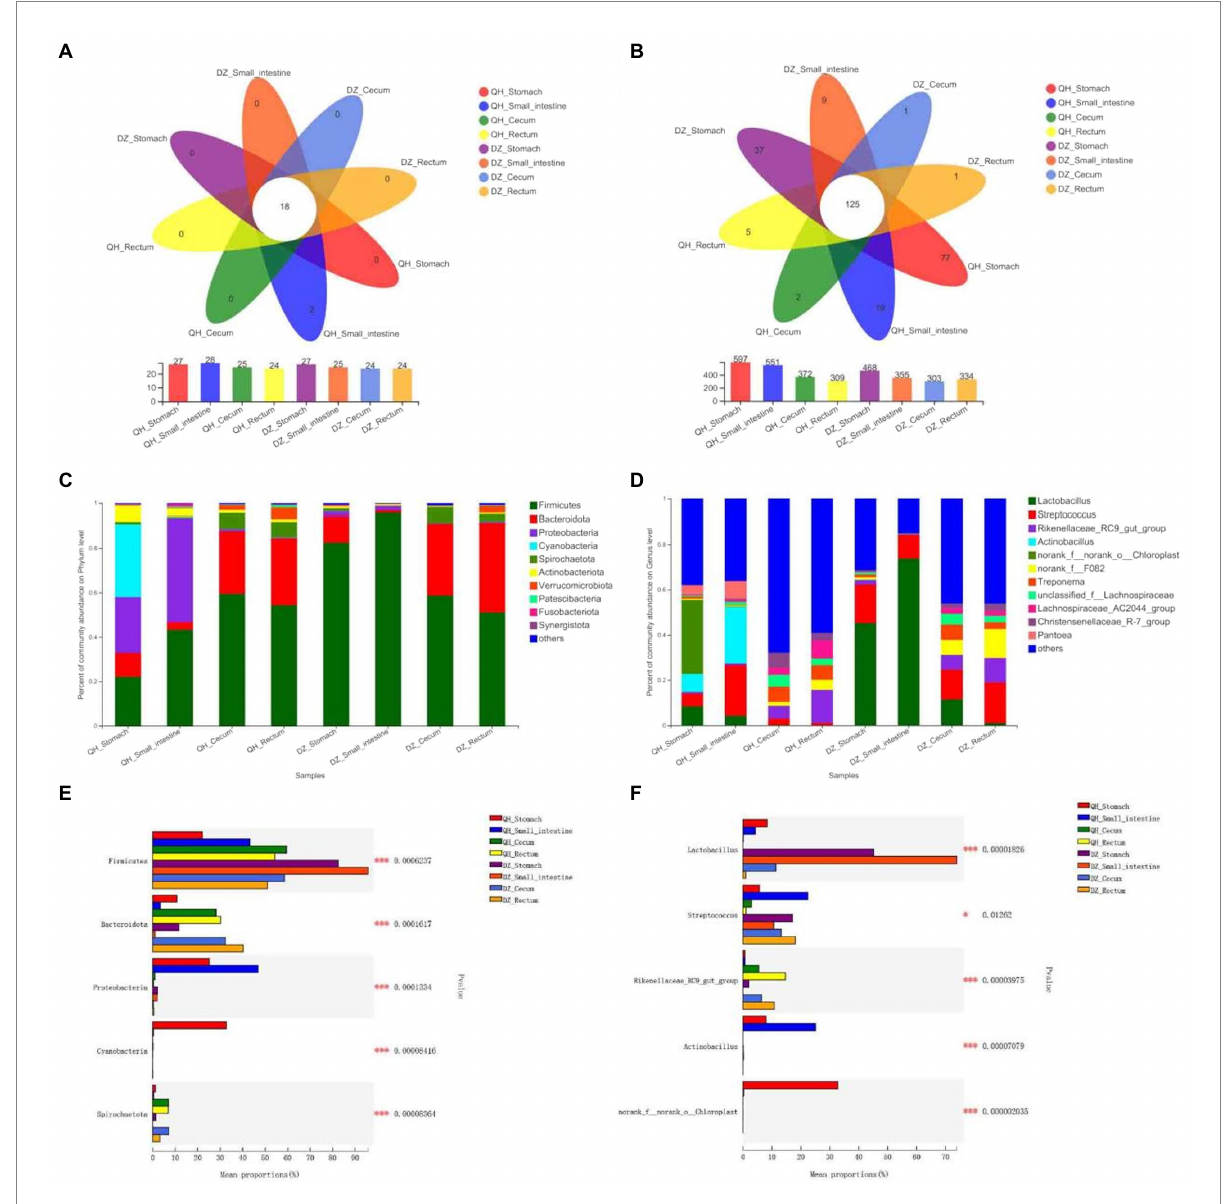
FIGURE 2 Composition of gut microbial community. Structure composition of related microbial communities in gut locations of phylum level (A,C,E) and genus level (B,D,F) . (A,B) Venn diagram. Numbers in the overlapping part represent the number of species shared by multiple groups, and the numbers in the non-overlapping part represent the number of species unique to the corresponding grouping. (C,D) Community column chart. The abscissa was the sample name, the ordinate was the proportion of species in the sample, the columns of different colors represented different species, and the length of the column represented the proportion of the species. (E,F) Multi-group comparison. The X -axis represented different groups, the boxes with different colors represented different groups, and the Y -axis represented the average relative abundance of a species in different